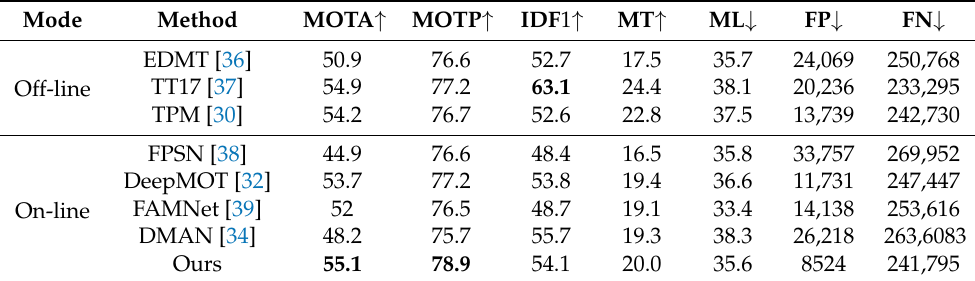
Table 2. Comparison of our algorithm with other state-of-the-art algorithms.